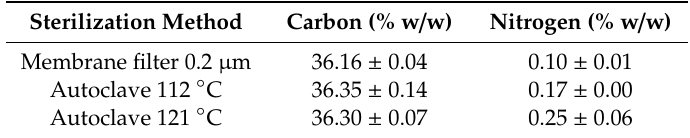
Table 3. Carbon and nitrogen contents in the hydrolysate after sterilization by different methods. 248